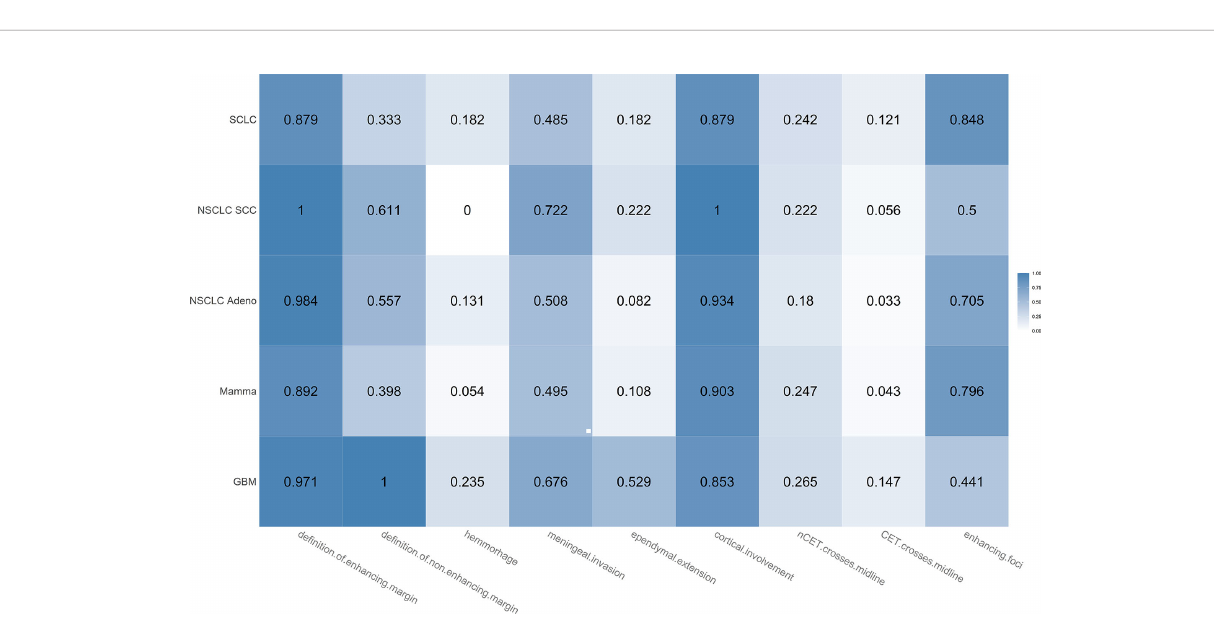
FIGURE 6 | Heatmap showing the proportions for the different appearance-based MR features broken down for the different histological subtypes of brain metastases (SCLC, NSCLC SCC, NSCLC adenocarcinoma, mamma carcinoma). Each proportion corresponds to the ratio: number of lesions with feature/total number of lesions. Darker color indicates a larger